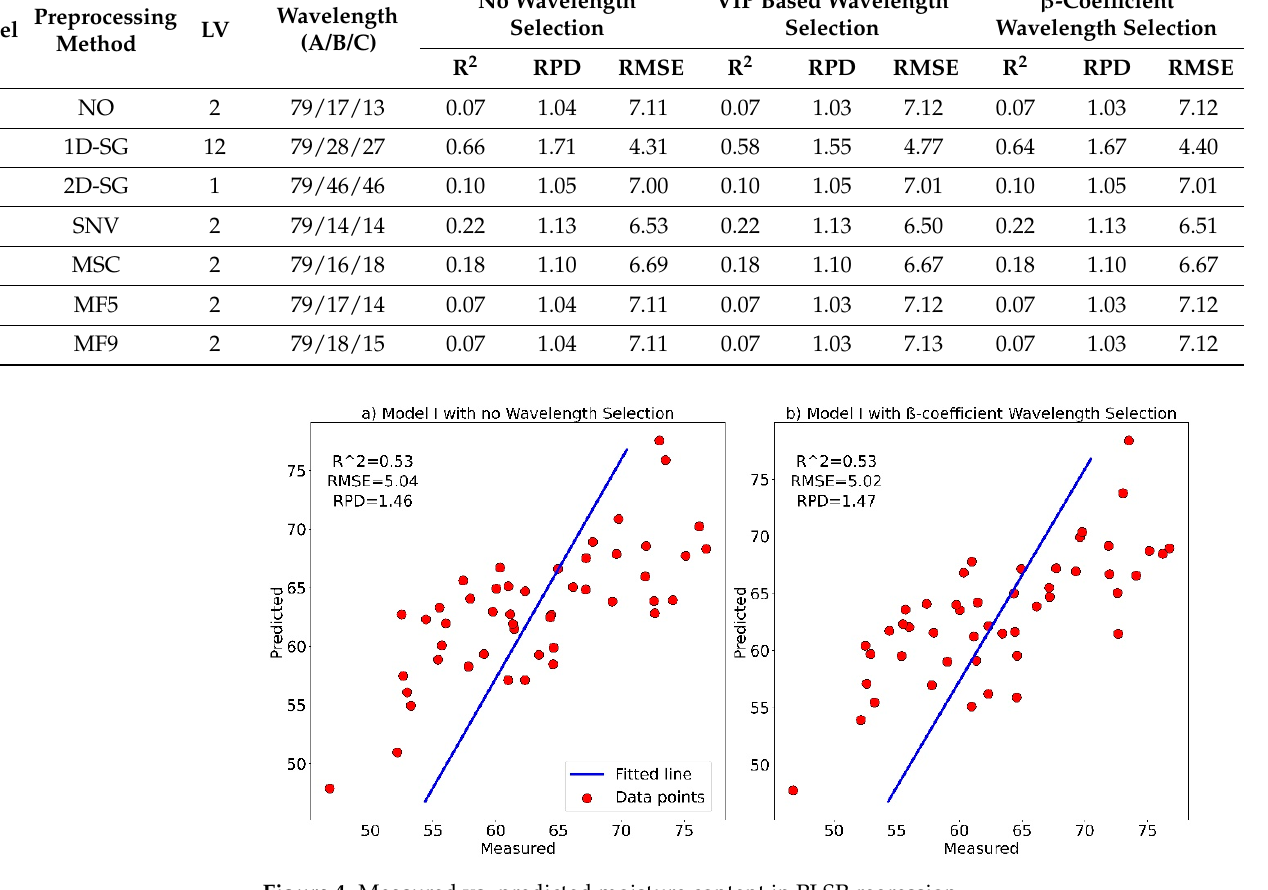
Figure 4. Measured vs. predicted moisture content in PLSR regression.